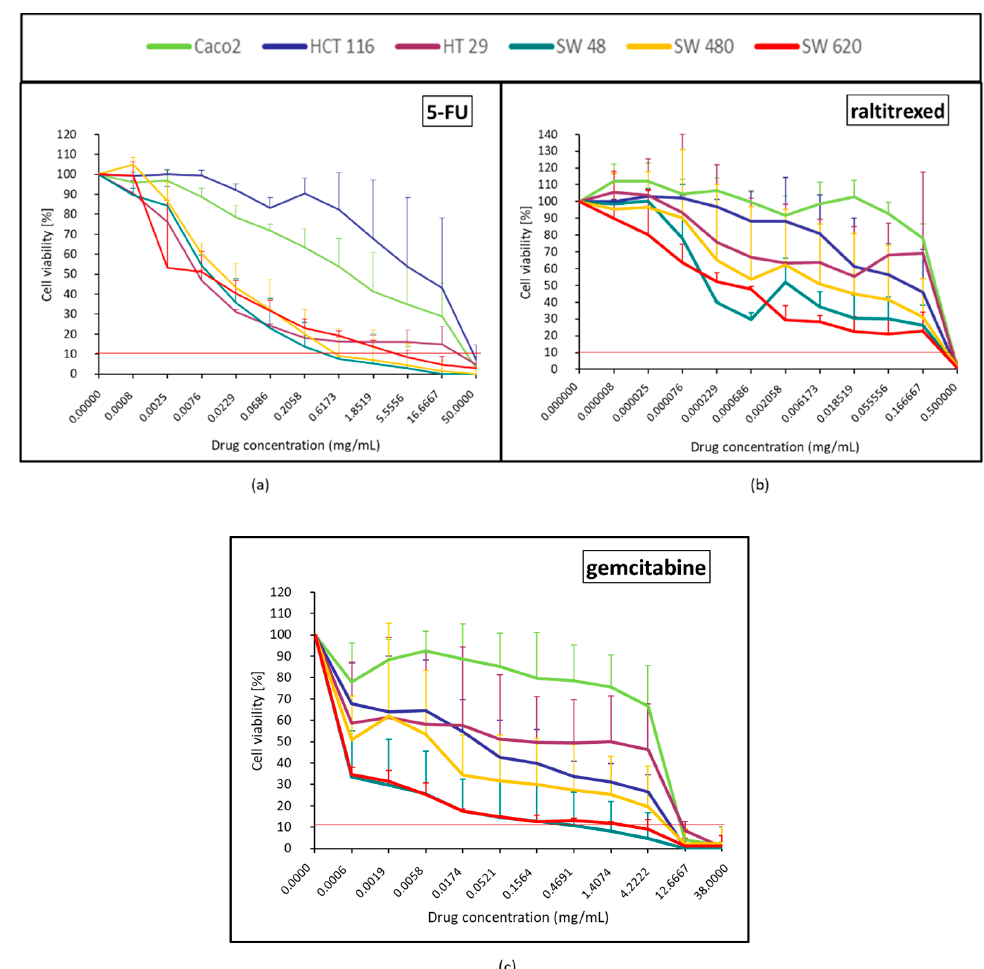
Figure 2. Colorectal cancer cell line viability curves (mean ± standard deviation) after a 30 min contact time with the 3 anti-metabolites: 5-FU ( a ), raltitrexed ( b ), and gemcitabine ( c ). The horizontal red line represents 10% of cell viability. The results are presented after normalization with the control cells (untreated condition).